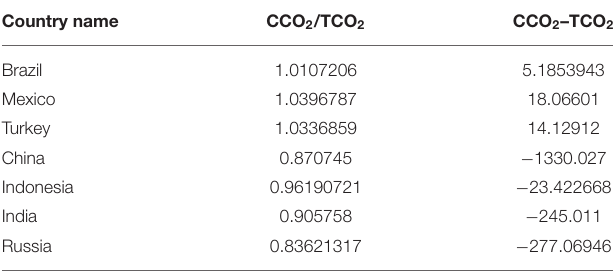
TABLE 1 | Ratios and difference for consumption and territory-based emissions. Country